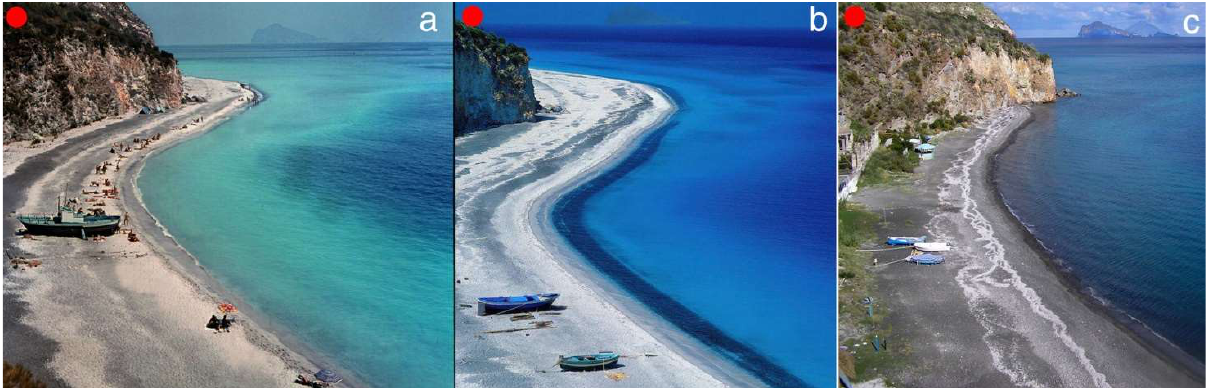
Figure 8. Images of Papesca beach from the end of 1970s to the beginning of the 1980s ( a , b ), showing the large extension of the beach at that time, due to abundant supply of pumice fragments moved by the littoral drift. Today ( c ), the same beach appears severely retreated (compare images with respect to the cliff in the background) and pumice fragments are locally accumulated only as narrow white stripes on the beach ridges. Location of pictures is in Figure 1 through the respective red-colored dot.